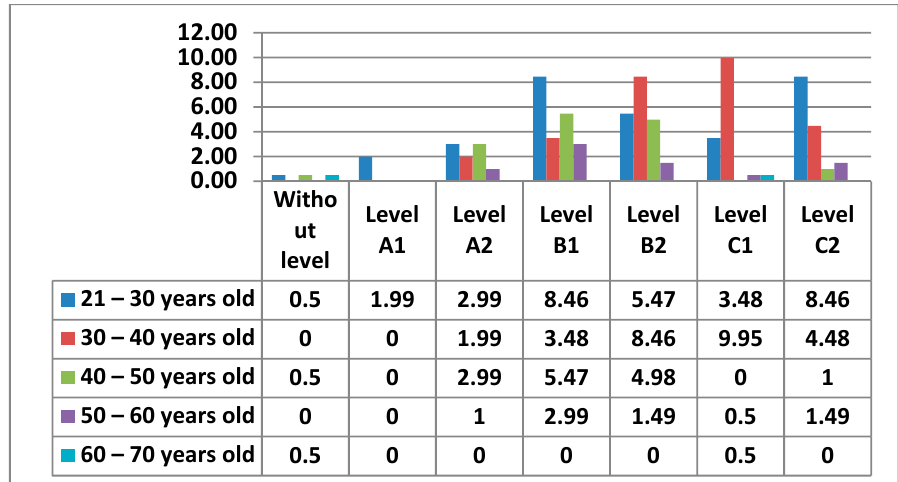
Figure 11. Level of digital competence in teachers by age in area 1.